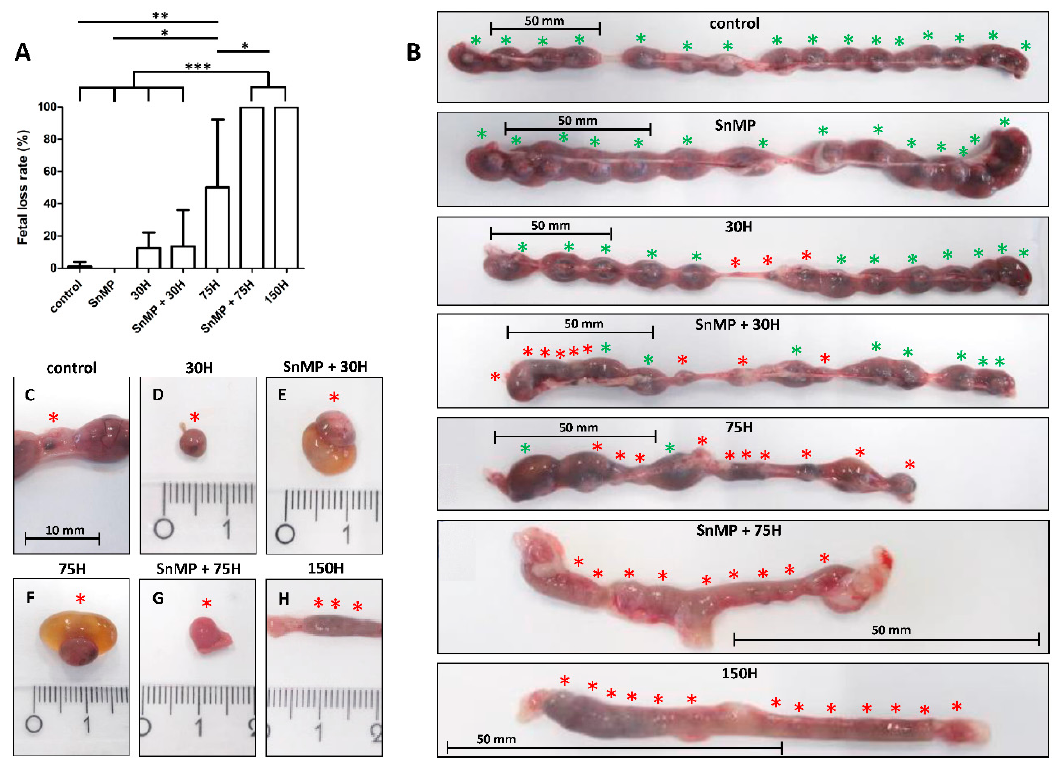
Figure 1. HO-activity protects against heme-induced abortion. ( A ) Bar chart of the fetal loss rate in pregnant mice determined at E16, compared for the different heme and / or SnMP administrations (control n = 6; SnMP n = 4; 30H n = 4; SnMP + 30H n = 5; 75H n = 7; SnMP + 75H n = 4; 150H n = 3). Data are shown as mean ± SD. * p < 0.05, ** p < 0.01, *** p < 0.001. ( B ) The isolated uteri were photographed, the green asterisk indicated a fetus, the red asterisk indicated a fetal resorption. A representative uterus per group is shown. ( C – G ) Isolated fetal resorptions from different groups (centimeter ruler). Fetal resorption showing an amniotic sac that contained an abnormal yellow-brownish pigmentation of the amniotic fluid ( E , F ), characteristic for the presence of free heme molecules. ( H ) Part of the uterus containing an amorphic mass as a result of total abortion (centimeter ruler).